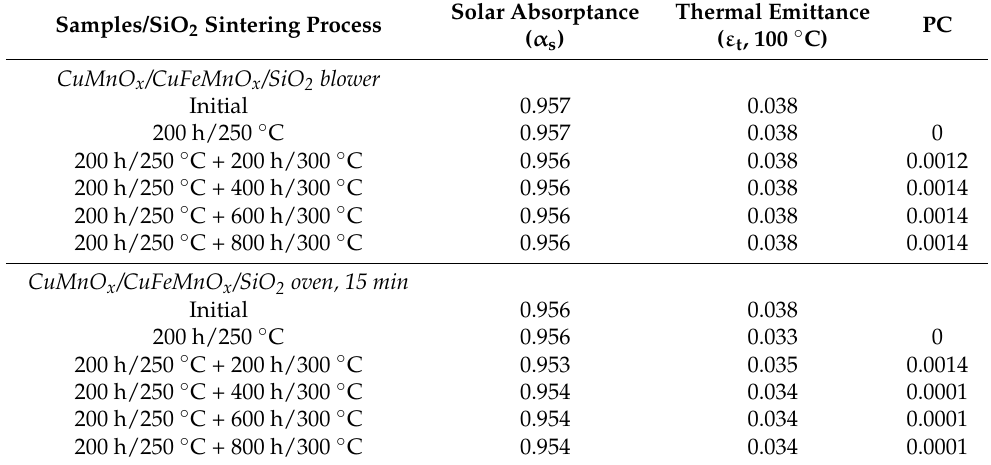
Table 4. Solar absorptance, thermal emittance and PC values calculated before and after different degradation intervals for the samples during the thermal stability test. All the values are the average of the values obtained for the six